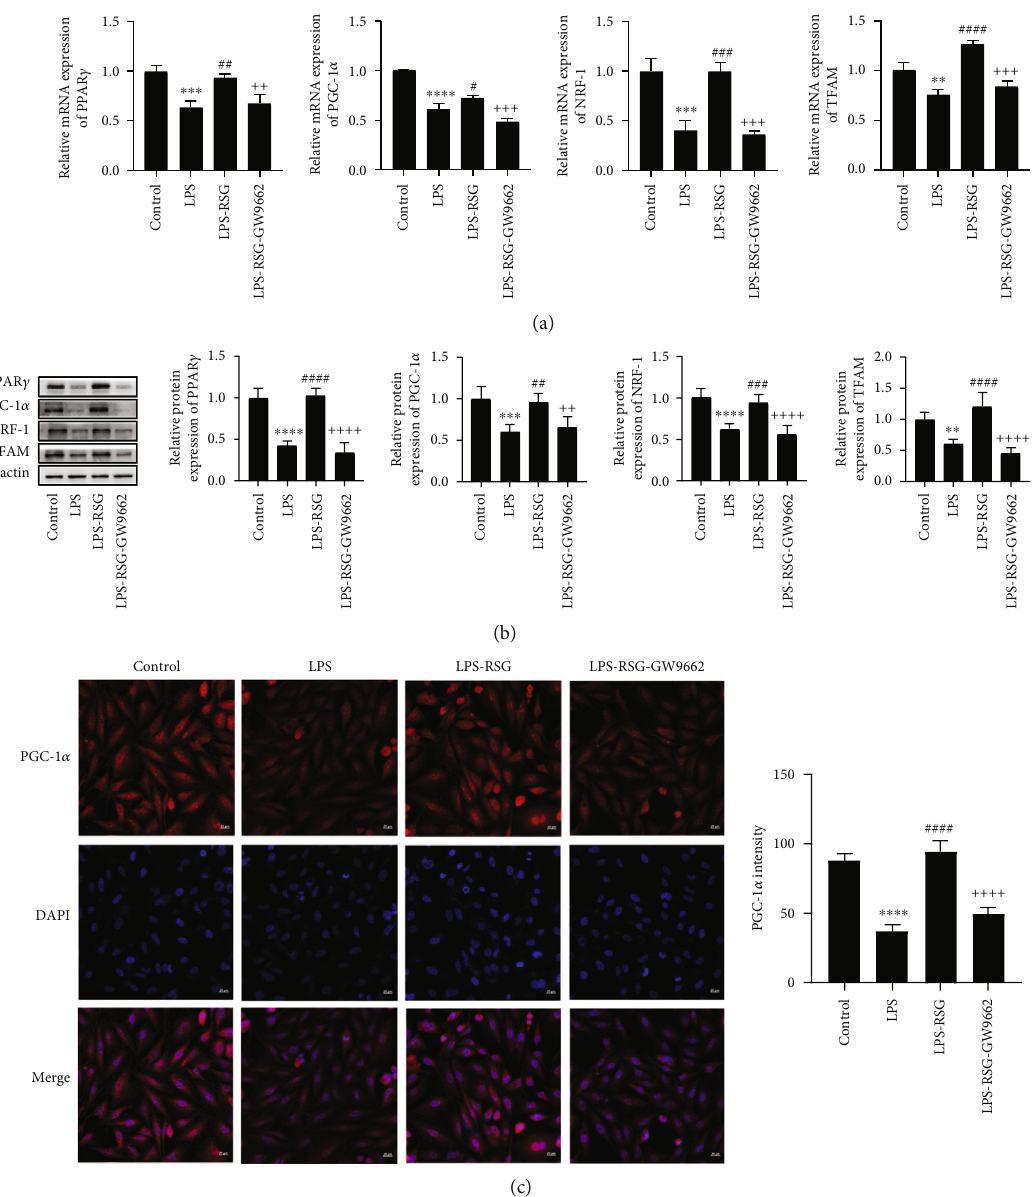
Figure 4: Activation of PPAR γ promoted mitochondrial biogenesis in alveolar epithelial cells. (a) Relative mRNA expressions of PPAR γ , PGC-1 α , NRF-1, and TFAM in A549 epithelial cells. (b) Western blotting and relative protein expressions of PPAR γ , PGC-1 α , NRF-1, and TFAM in A549 epithelial cells. (c) Immuno fl uorescence staining and mean fl uorescence intensity of PGC-1 α in A549 epithelial cells (original magni fi cation, × 200). Data are presented as mean ± SD . ∗∗ p < 0 : 01 , ∗∗∗ p < 0 : 001 , ∗∗∗∗ p < 0 : 0001 vs. Control, # p < 0 : 05 , ## p < 0 : 01 , ### p < 0 : 001 , #### p < 0 : 0001 vs. LPS, ++ p < 0 : 01 , +++ p < 0 : 001 , ++++ p < 0 : 0001 vs.